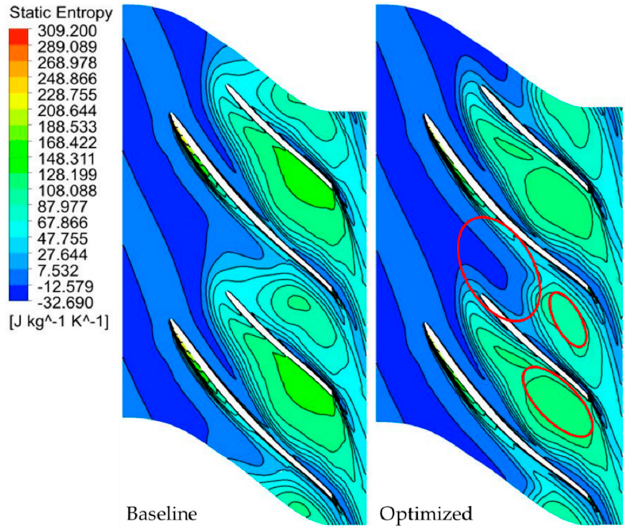
Figure 20. Static entropy distribution for span 0.8 at the blade-to-blade contour.